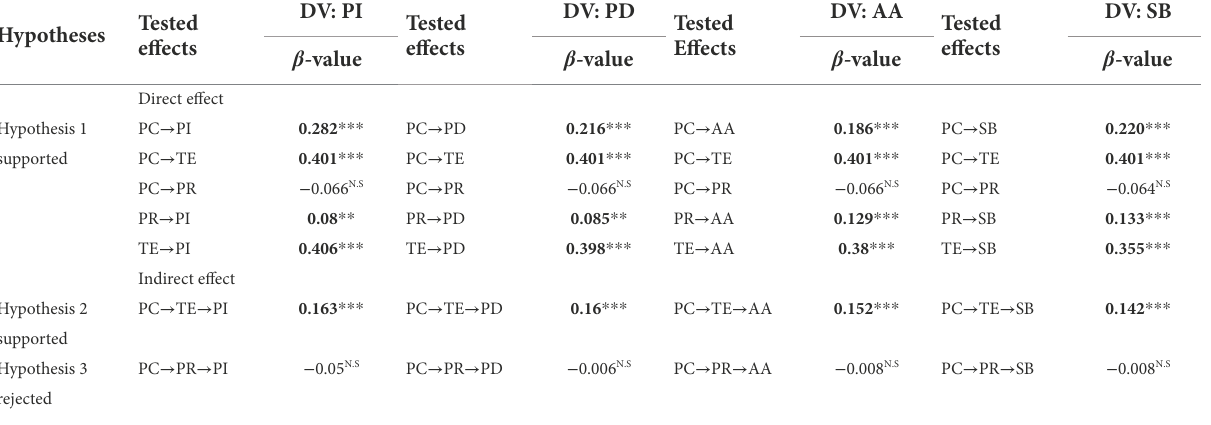
TABLE 5 Inner model evaluation (hypotheses testing).